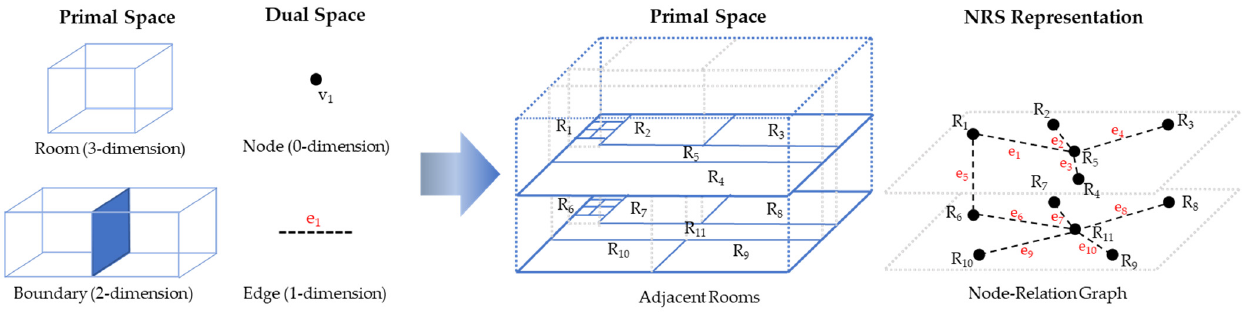
Figure 2. Using the concept of NRS to express topological relationships between 3D indoor spaces